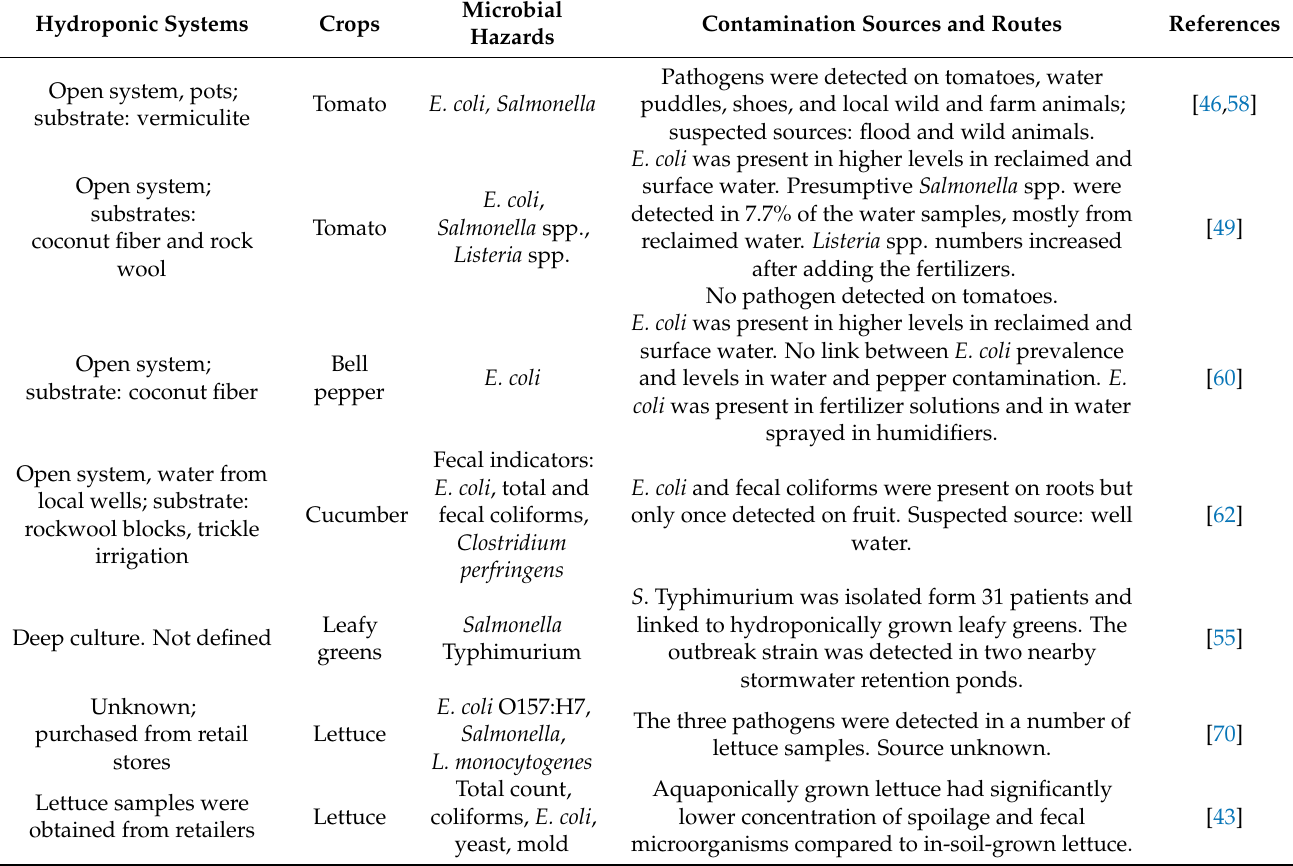
Table 1. Sources and routes of contamination in commercial hydroponic